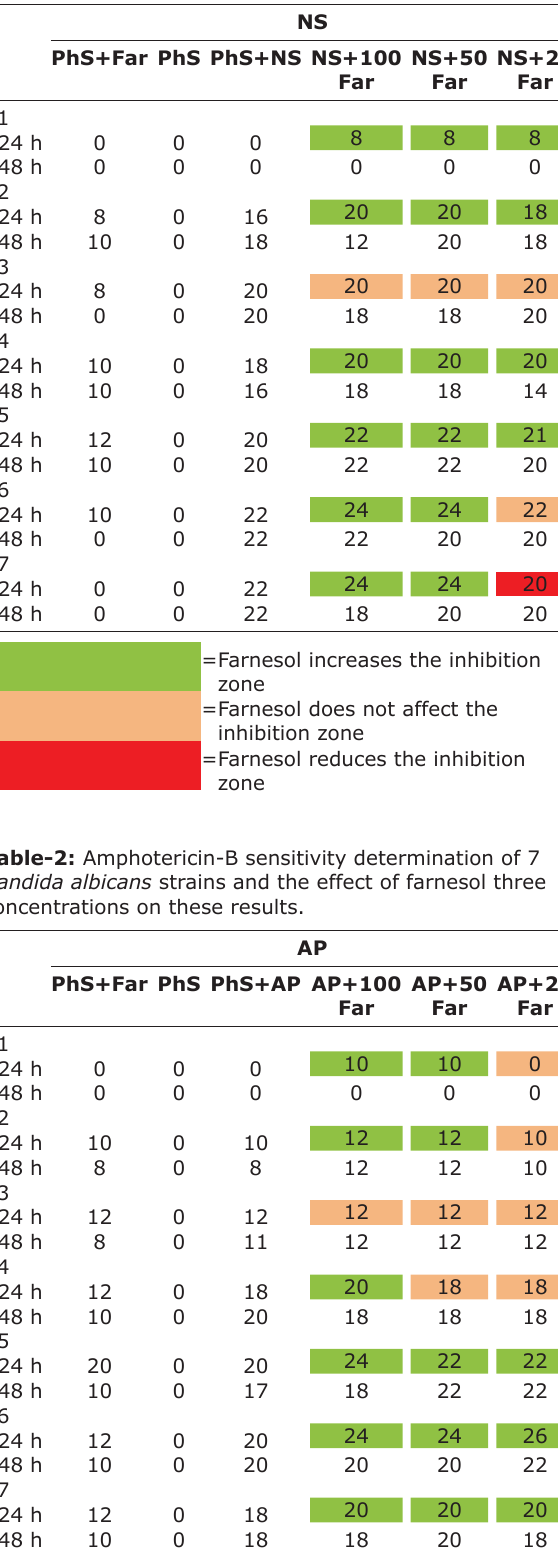
Table-1: Nystatin sensitivity determination of 7 Candida albicans strains and the effect of farnesol three concentrations on these results.